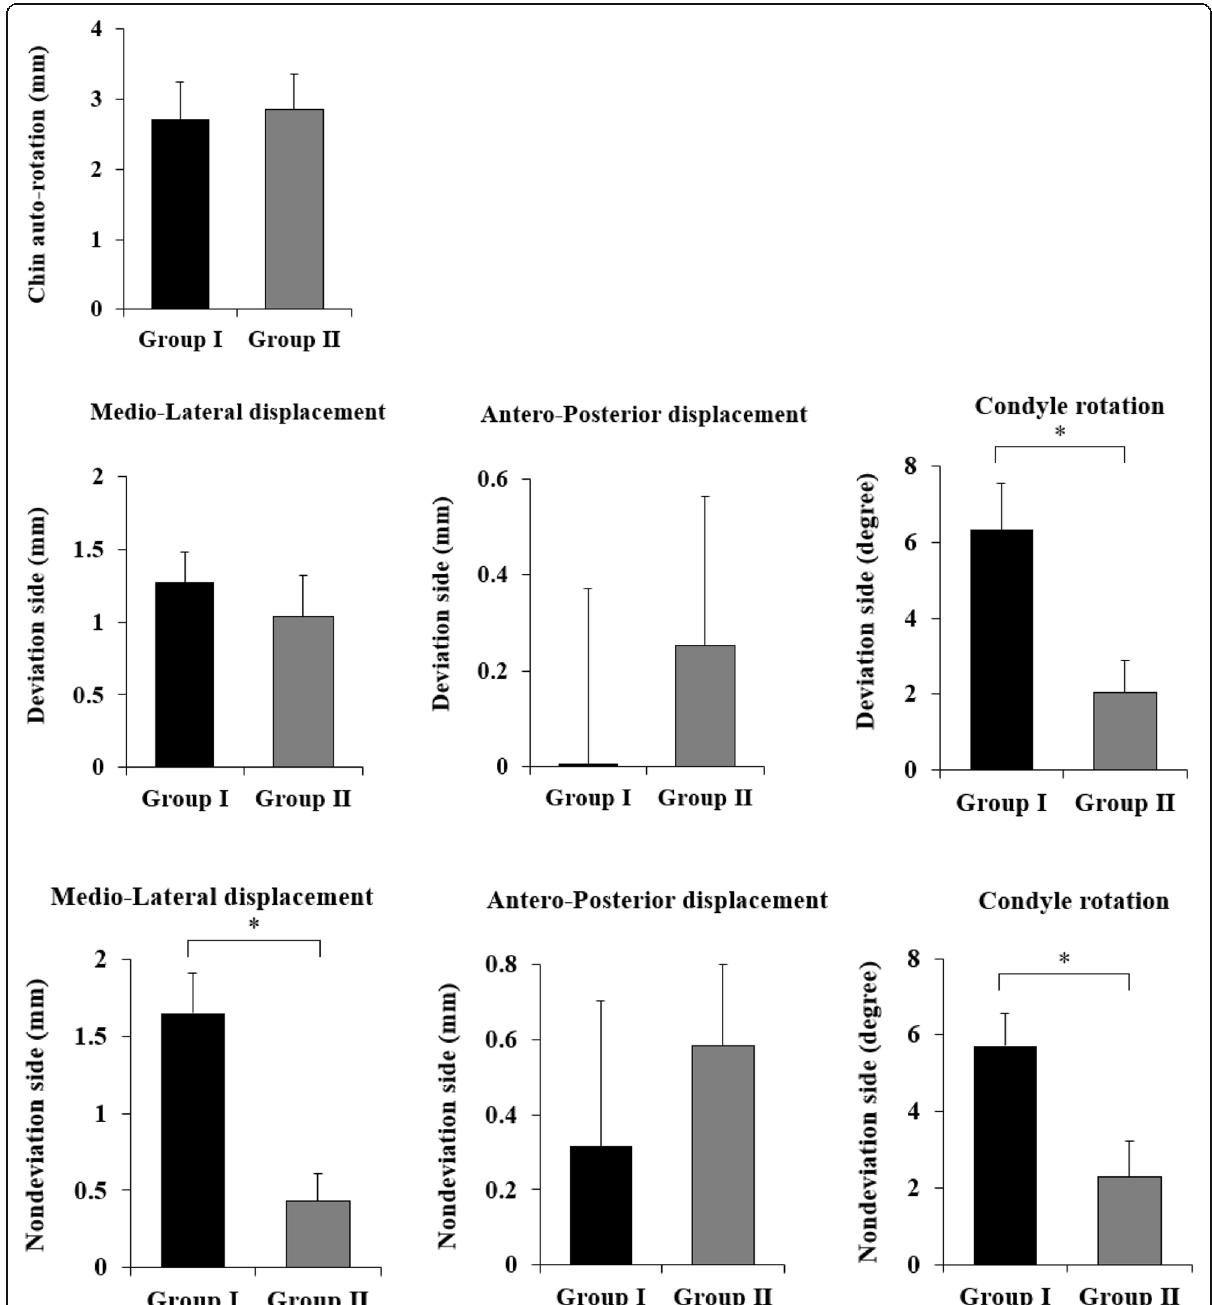
Fig. 5 Comparison of anteroposterior displacement, mediolateral displacement, condylar rotation in Group I and Group II on the deviation side and non-deviation